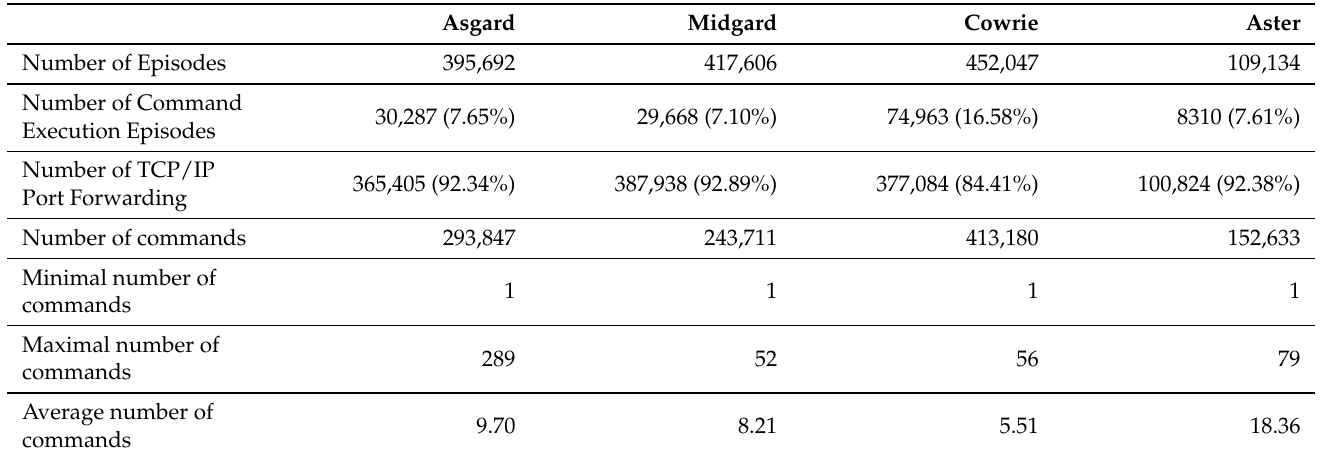
Table 1. Description of attack